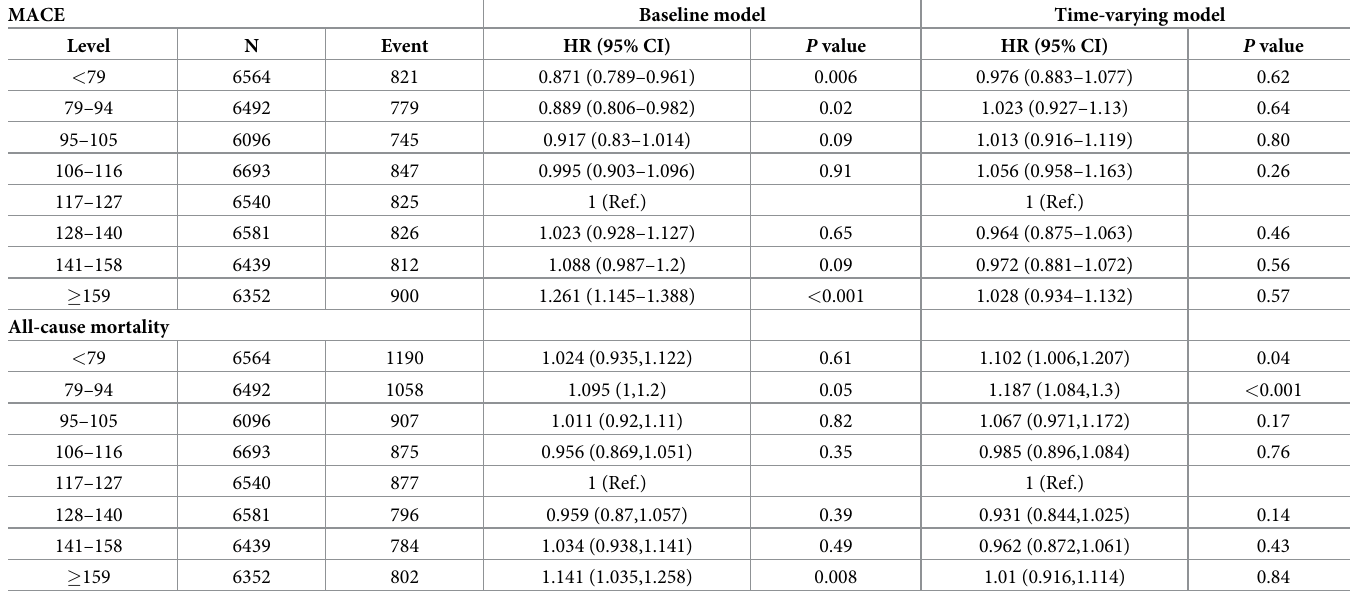
Table 2. Association of serum LDL-c with MACEs and all-cause mortality, stratified by octile categories in patients with CKD and diabetes. MACE Baseline model Time-varying model Level